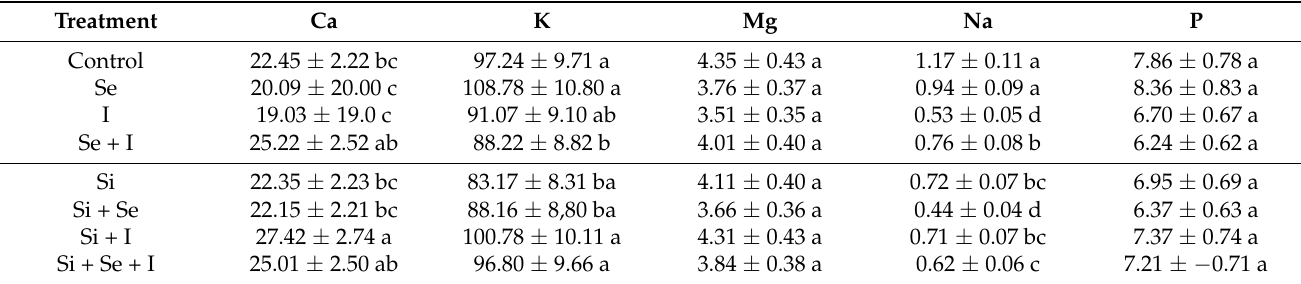
Table 5. Levels of macro-element accumulation in chervil shoots under single and joint application of Se, I and Si.